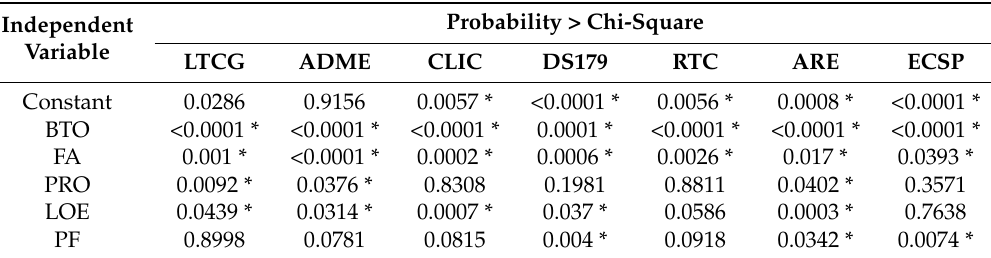
Table 4. Summary of Awareness Models for the Seven Tax Incentives.